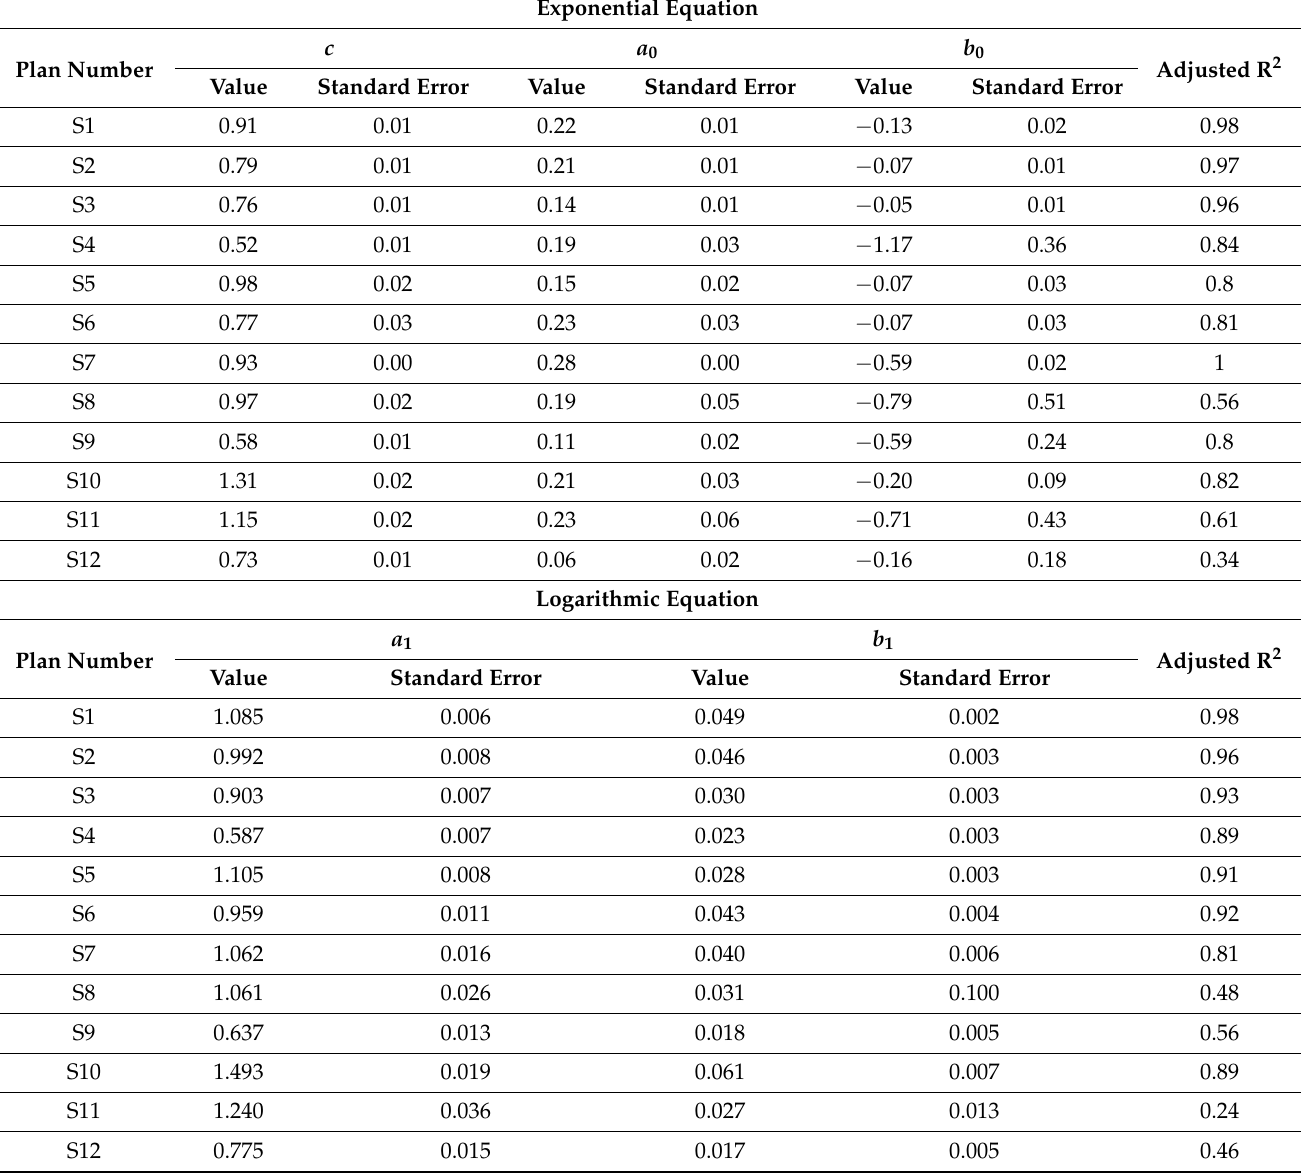
Table 6. MTD attenuation prediction equation